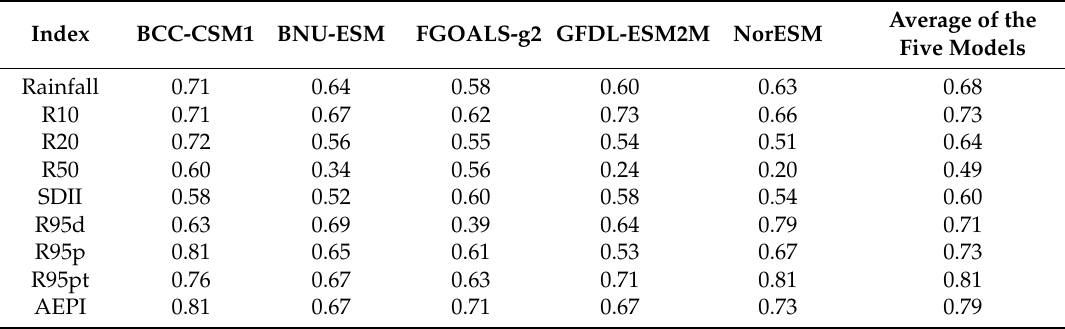
Table A1. The Pearson correlation coefficients for extreme precipitation indices between CMIP5 models and CMA observations.